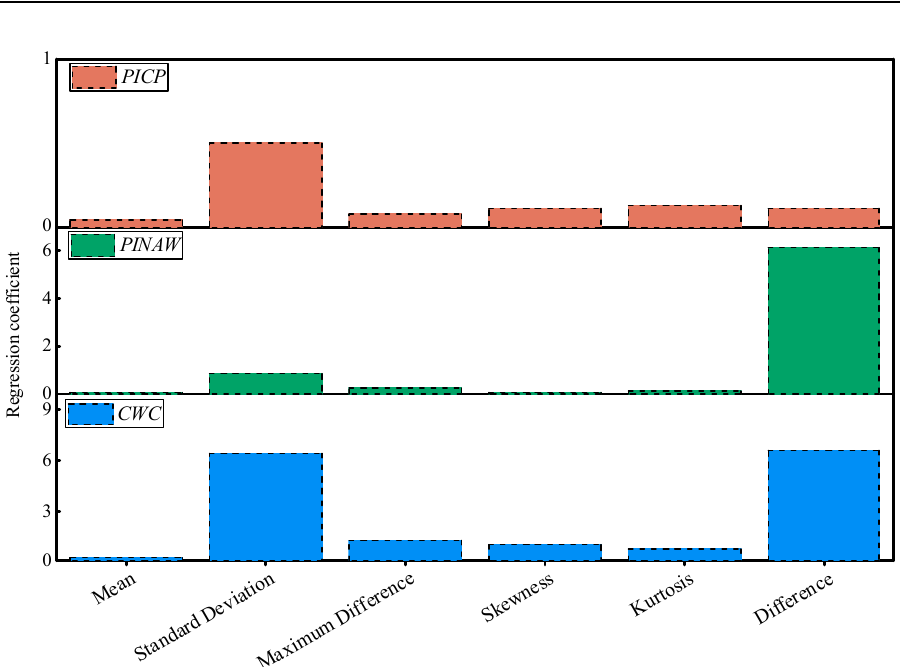
Figure 8. Regression coefficients.